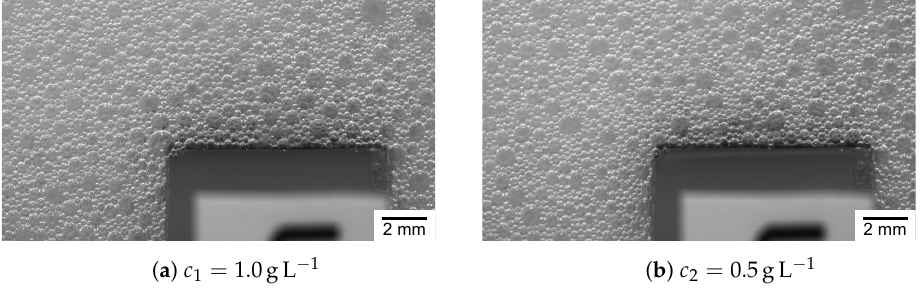
Figure 2. Foam bubbles at the weir, imaged through the transparent side wall: for both SDS surfactant concentrations in ( a , b ), the bubble size range spans from approximately 0.2mm to